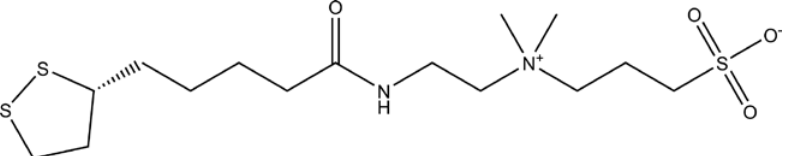
Figure 5: Chemical structure of the thiol-terminated sulfobetaine used by Jolly et al. (2015): ( R )-3-((2-(5-(1,2-dithiolan-3-yl)pentanamido)- ethyl)dimethylammonio)propane-1-sulfonate).